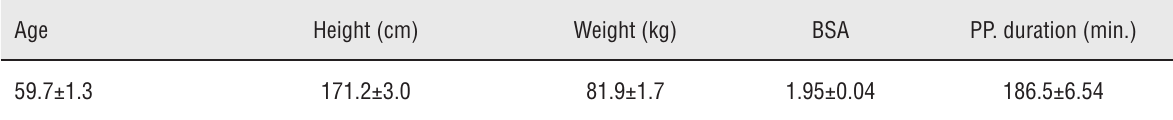
Table 1 - Characteristics of the patients and duration of